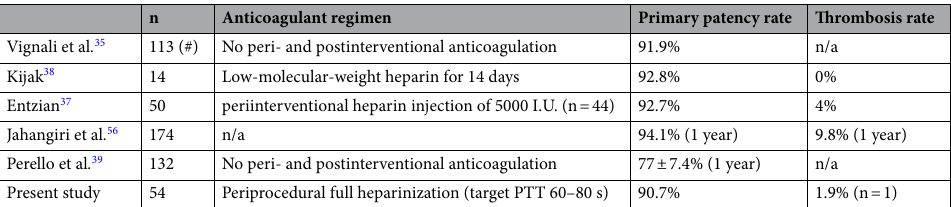
Table 4. Comparative studies. The Viator stent was used in each of the studies reported, if not otherwise specified. The primary patency and thrombosis rates are given for six months, if not otherwise specified. (#) Modification of TIPSs at primary installation with one additional coated stent each (n =